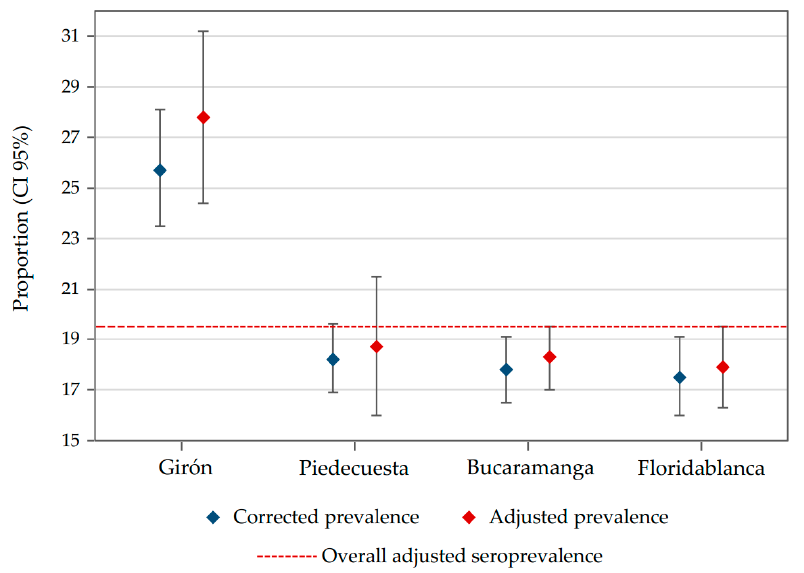
Figure 3. Seroprevalence by municipalities. Dashed line represents the overall adjusted seropreva- lence estimated in our study. This line was added for comparison purposes.